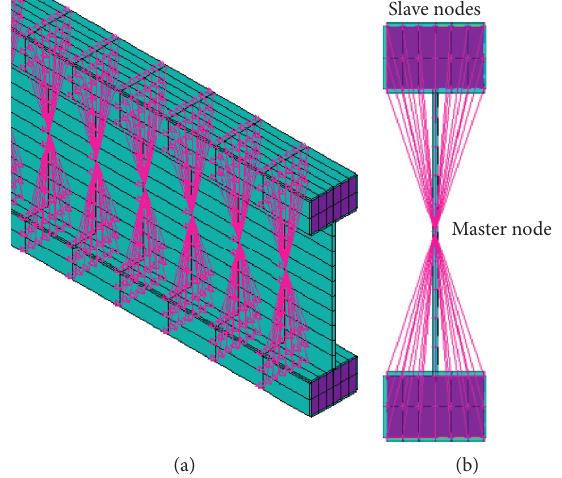
Figure 8: Rigid peripheral applications along the length of girder (constraint rotation around z -axis). (a) Rigid peripheral applica- tions. (b) Master and slave nodes.